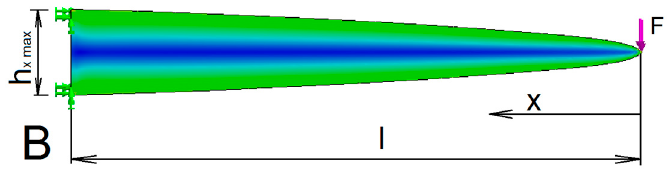
Figure 6. Load of the uniform stress cantilever of constant width (stress diagram).